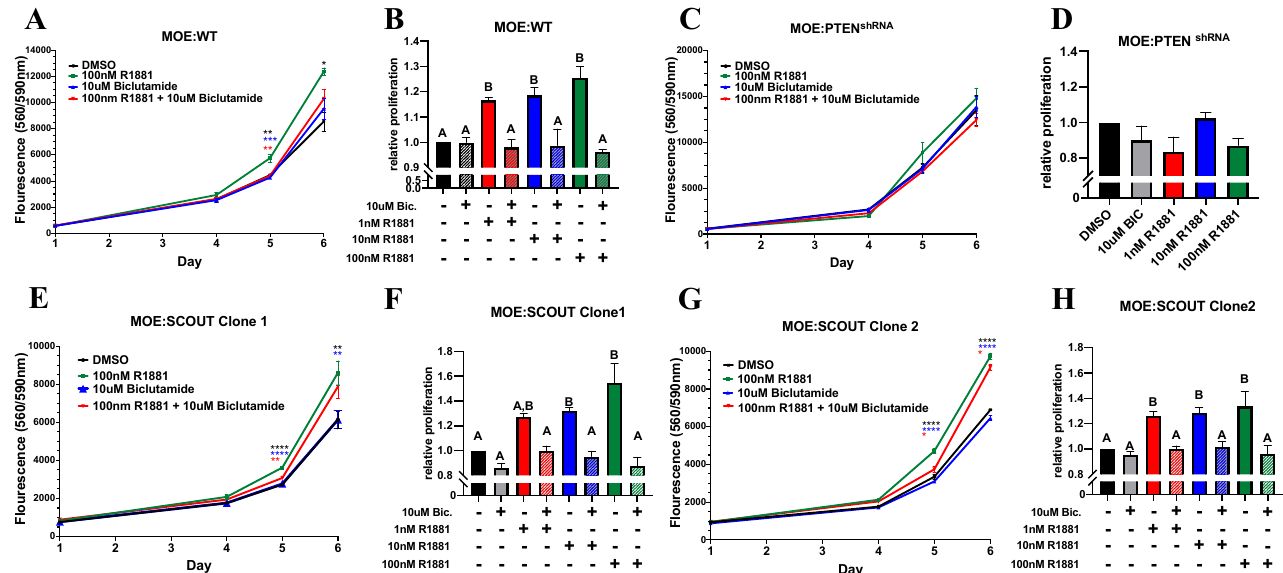
Figure 2. Androgens increase in vitro proliferation of murine oviductal epithelial cells. ( A , C , E , G ) Cell viability was measured by CellTiter Blue assay after exposure to DMSO, 100 nM R1881, 10 µ M bicalutamide, or a combination for 4, 5, and 6 days (each day was individually analyzed using a one-way ANOVA followed by a Dunnett’s post hoc, n ≥ 4, Significant differences from control are represented by * p < 0.05, ** p < 0.01, *** p < 0.001, **** p < 0.0001). ( B , D , F , H ) Cells were cultured in various concentrations of R1881 with and without 10 µ M bicalutamide for 5 days. Relative proliferation was measured via Sulforhodamine B (SRB) assay ( n ≥ 3, one-way ANOVA followed by a Tukey’s post-hoc where p < 0.05, letters above bars indicate differences between groups at p < 0.05). Data displayed as mean ±